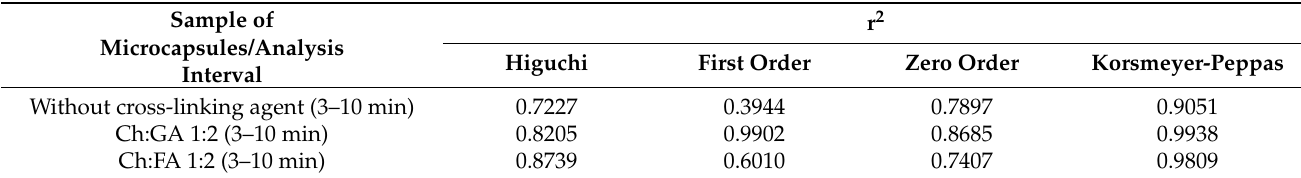
Table 5. Values of the correlation coefficient (r 2 ) for the applied mathematical models.